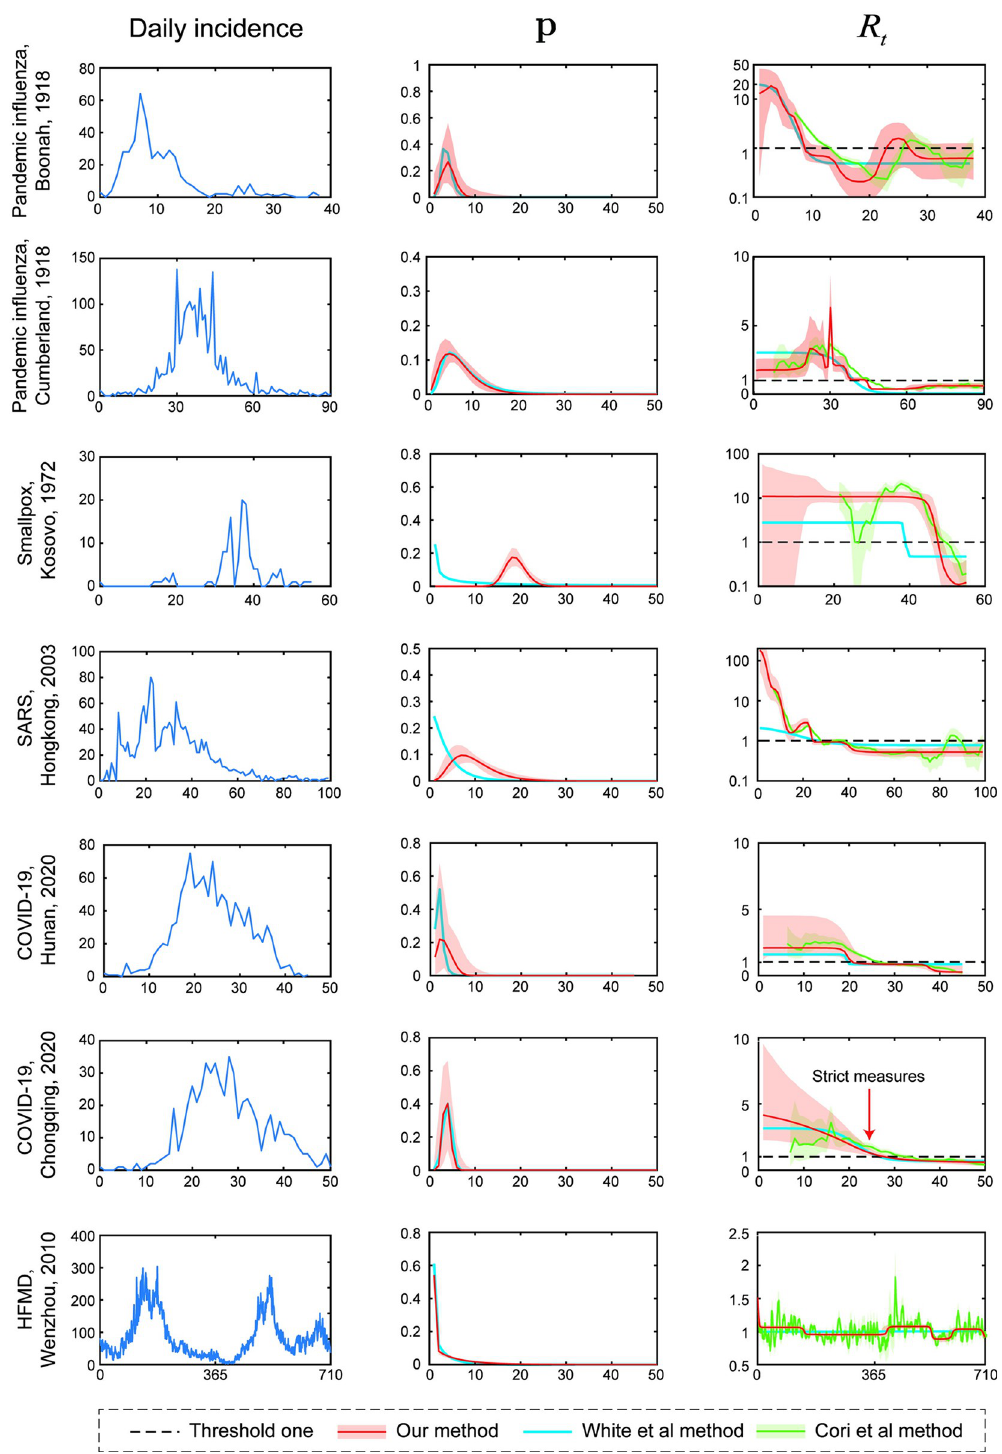
Fig 7. Application of our method to seven historical epidemics. The first column shows daily epidemic curves (from top to bottom) for the pandemic influenza in Boonah, 1918; the pandemic influenza in Cumberland, 1918; the smallpox in Kosovo, February–April 1972; the SARS in Hong Kong, February–June 2003; the COVID-19 in Hunan, 2020; the COVID-19 in Chongqing, 2020; and HFMD in Wenzhou, 2010–2011. The second and third columns show estimates of the serial interval p and instantaneous reproductive number R , respectively. The red lines and light red area, the blue lines, the green lines t